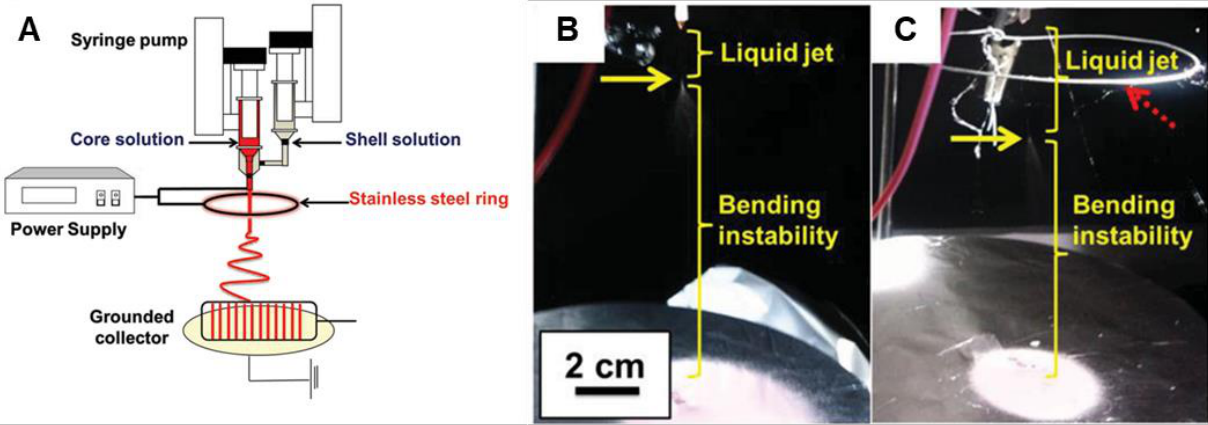
Figure 19. Use of a secondary electric field below the syringe ( A ) results in prolonged liquid jets ( B , C ) that enhance charge transport, resulting in dramatically enhanced mobility [200]. Reprinted with permission from Ref. [200]. Copyright 2015, John Wiley & Sons.